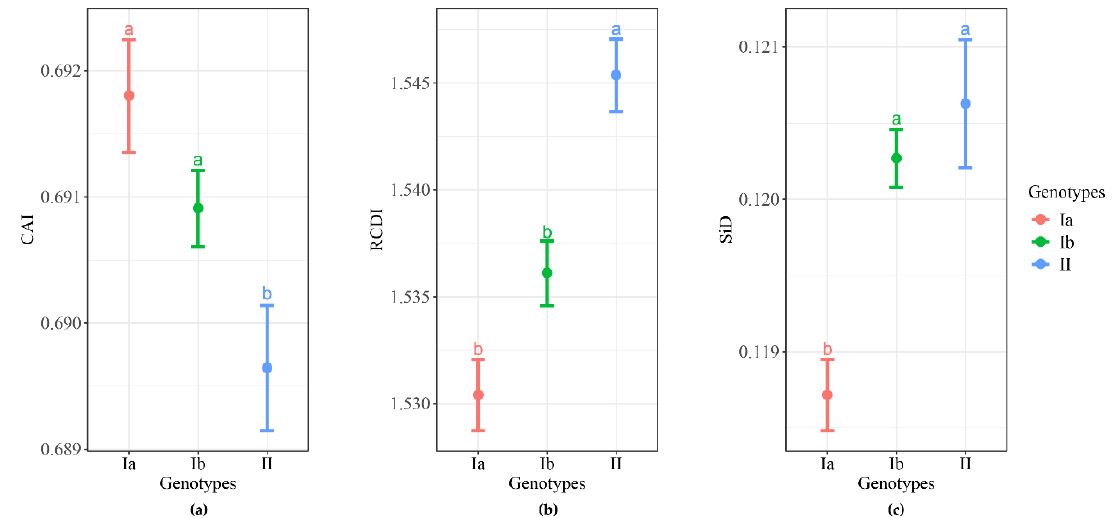
Figure 7. Analysis of TGEV adaptation to pig. ( a ) Codon adaptation index (CAI) of the TGEV complete CDS to pig. ( b ) Codon deoptimization index (RCDI) of the TGEV complete CDS to pig. ( c ) Similarity index (SiD) of the TGEV complete CDS to pig. Different lowercase letters indicate significant difference at the 5% level. Genotypes Ia, Ib, and II are represented in orange, green, and blue, respectively.